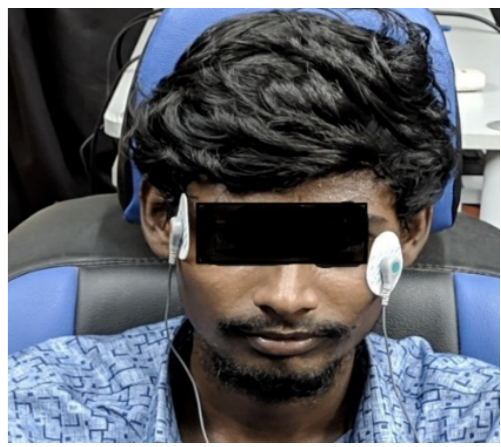
Figure 4 . EOG electrode placement. Figure 4. EOG electrode